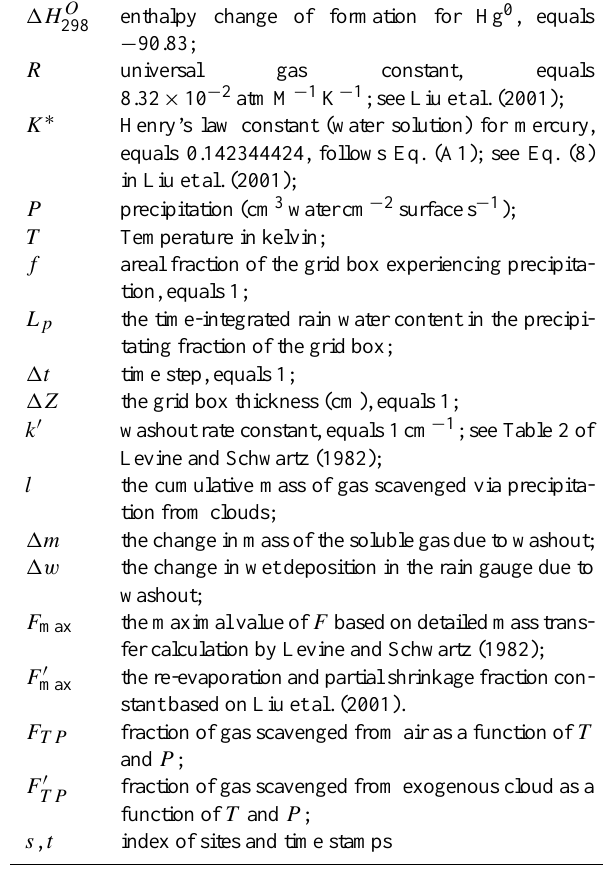
Table A1. List of